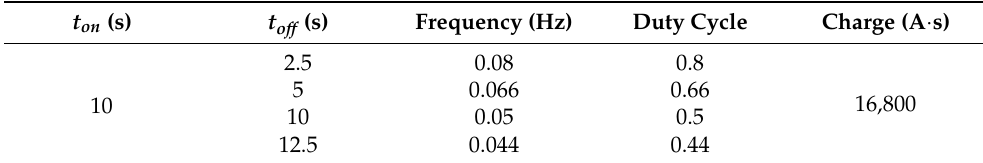
Table 3. Pulse parameters considered for the investigation of the effect of duty cycle on the ED system.